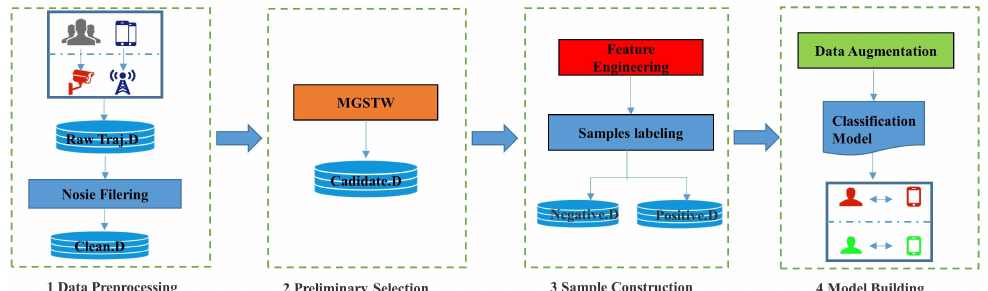
Figure 1. The framework of heterogeneous face–phone trajectory